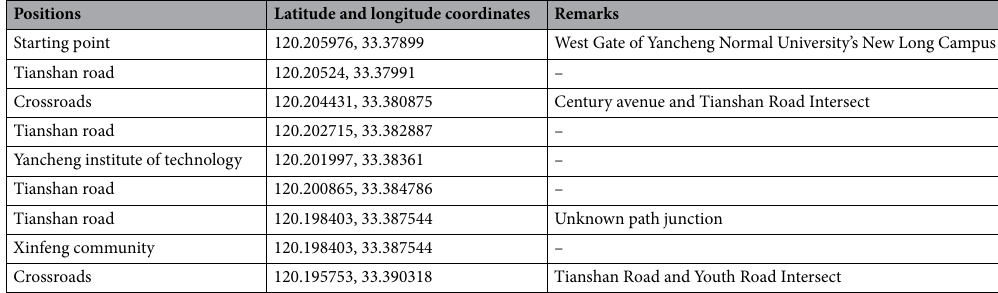
Table 10. The table mainly includes location, longitude and latitude coordinates and remarks. The location is divided into Starting point and Tianshan road. The longitude and latitude coordinates are consistent with the location.